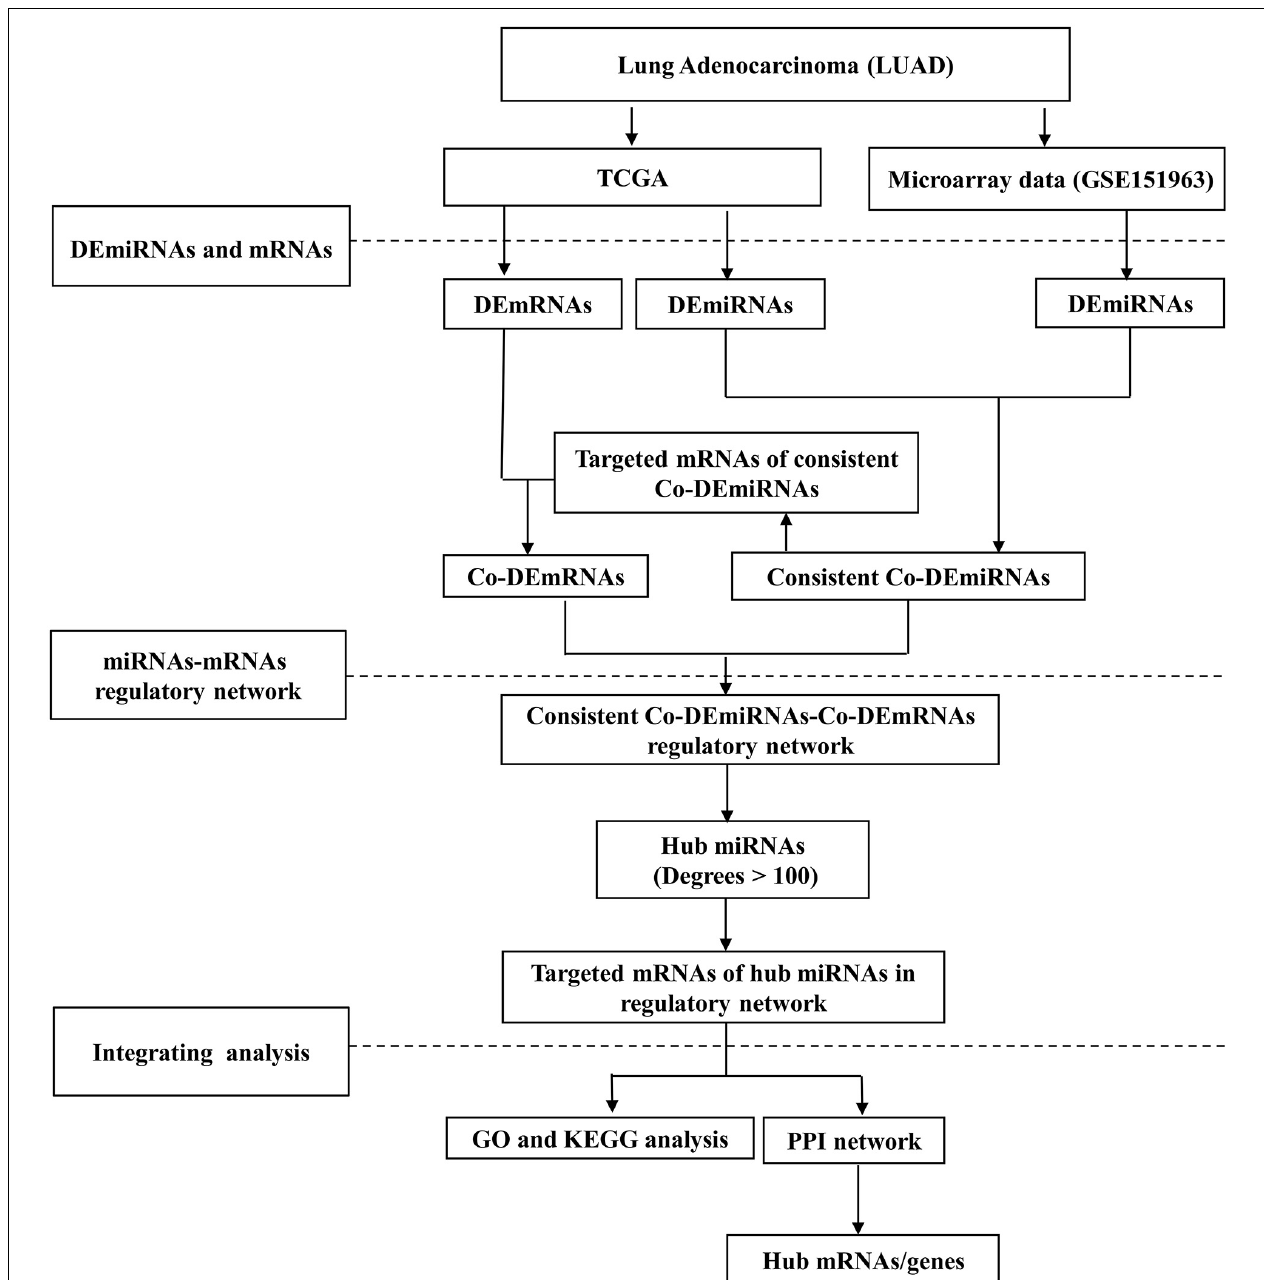
FIGURE 1 | The study workflow. LUAD, lung adenocarcinoma; DE, differential expression; Co-DE, common differentially expressed; Co-mRNAs, common mRNAs; TCGA, the Cancer Genome Atlas; GO, gene ontology; KEGG, Kyoto Encyclopedia of Genes and Genomes; PPI, protein–protein interaction.